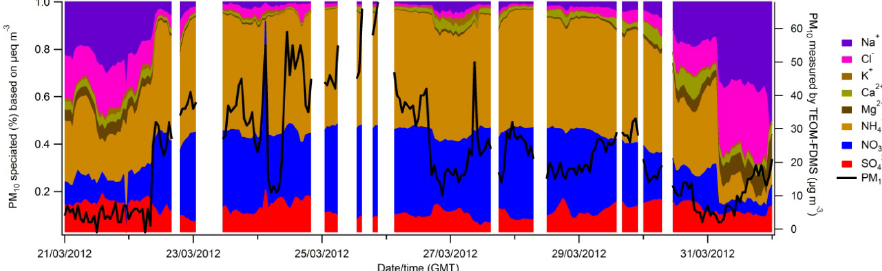
Figure 10. Relative PM 10 water-soluble aerosol composition during an example pollution event observed at a rural Scottish EMEP site (Auchencorth